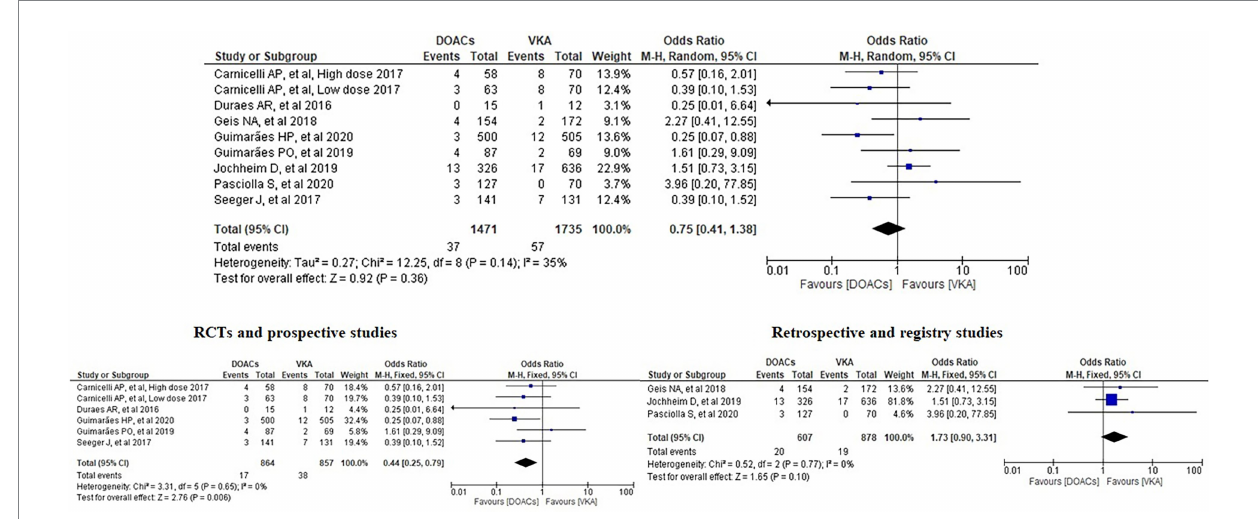
FIGURE 6 Forest plot of stroke for DOACs compared with VKA along with subgroup analysis. M-H, Mantel–Haenszel test; CI, confidence interval.